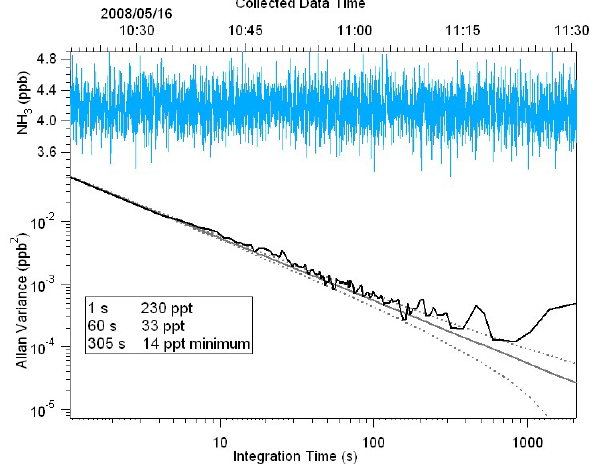
Fig. 2. Instrument noise and detection limit can be estimated us- ing an Allan variance plot. Upper trace displays a one hour long measurement from an NH 3 gas cylinder at 1Hz; lower trace shows the Allan variance for the data set with 230ppt of noise in 1s and a minimum of 14ppt noise with approximately 5min averaging. The detection limit can be defined as 3*noise and is equal to 690ppt at 1Hz.